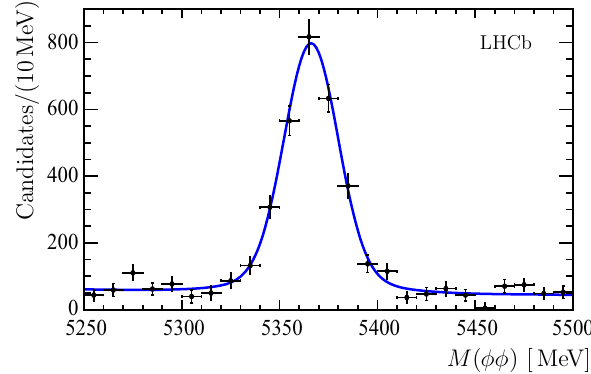
Fig. 9 Invariant mass spectrum of the φφ combinations in the region of the B 0 s mass, including the fit function described in the text